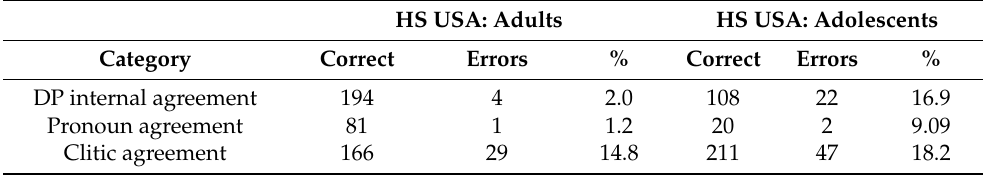
Table 5. Results. US Greek Heritage speakers (HSs), illustrating percentage of errors.